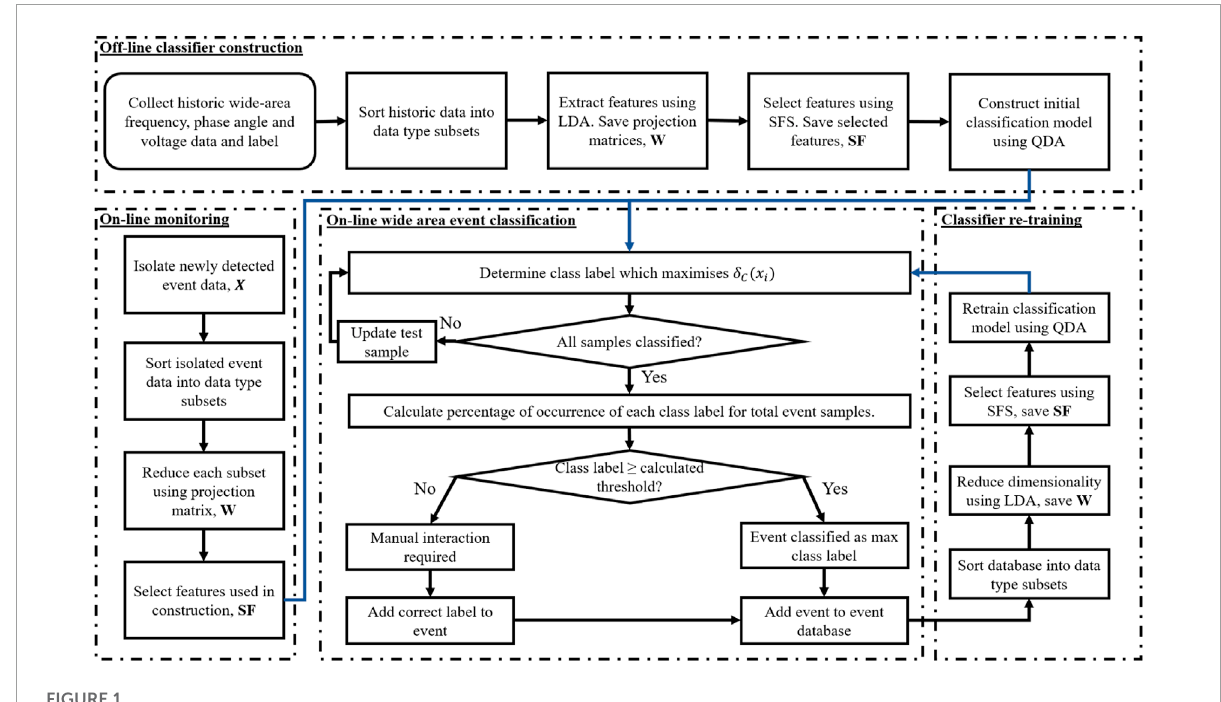
FIGURE 1 Power system event classification (PSEC) process